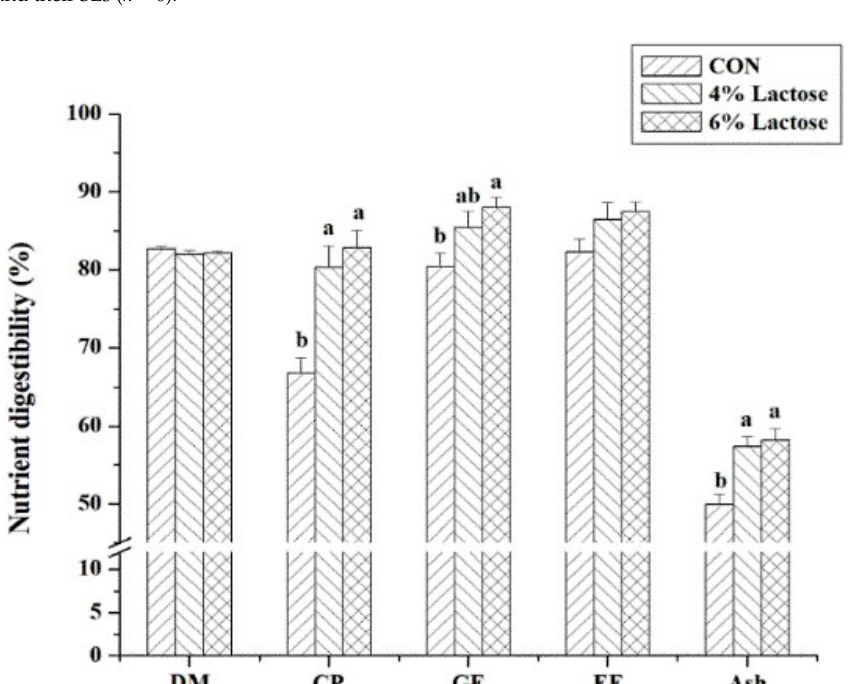
Figure 1. Effect of dietary lactose supplementation on nutrient digestibility in weaned piglets. Values are means ± SEs; n = 12. Values with different letters are significantly different ( p < 0.05). CON, basal diet; 4% Lactose, diet supplemented with 4% lactose; 6% Lactose, diet supplemented with 6% lactose; DM = dry matter; CP = crude protein; GE = gross energy; EE = ether extract.